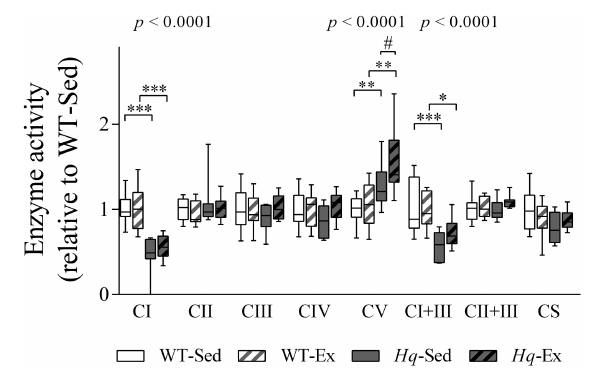
FIGURE 8 | OXPHOS enzymatic activities in brain homogenates. Enzyme activities in total brain homogenates of wild-type sedentary (WT-Sed, n = 12), and exercise-trained (WT-Ex, n = 11) mice, and of Hq sedentary ( Hq -Sed, n = 11) and exercise-trained ( Hq -Ex, n = 10) mice. Data (median, interquartile range, and min and max values) are expressed relative to levels in the WT-Sed group. Significant p- values for the group effect (Kruskal-Wallis test) are shown above the corresponding boxes. Symbols for significant differences in post hoc pairwise comparisons: ∗ p < 0.05; ∗∗ p < 0.01; ∗∗∗ p < 0.001 for Hq -Sed vs. WT-Sed, and Hq -Ex vs. WT-Ex; # p < 0.05 for Hq -Ex vs. Hq -Sed. Abbreviations: CI, II, III, IV, and V, respiratory complexes I, II, III, IV, and